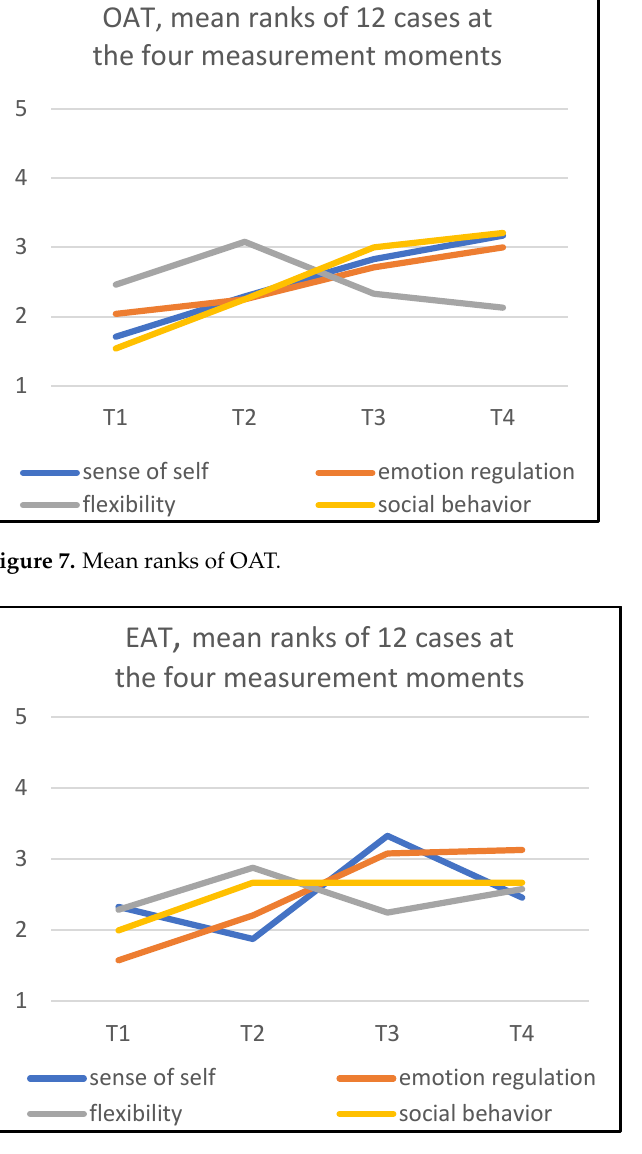
Figure 8. Mean ranks of EAT.